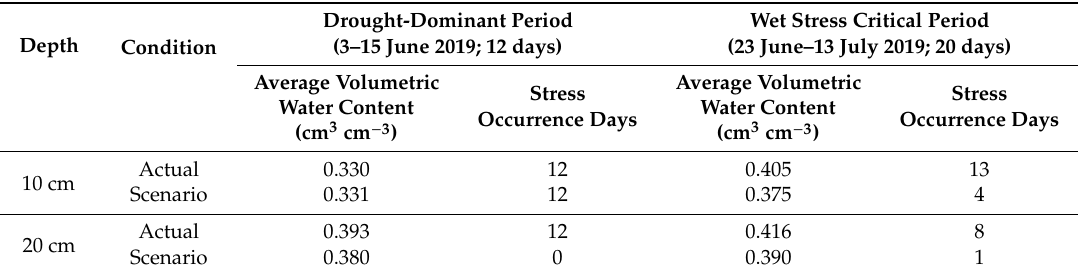
Figure 9. Drought and wet stresses under actual and scenario conditions in 2019. ( a ) Drought stress; ( b ) wet stress. The critical growth periods for drought and wet stresses were defined based on Çakir [3] and Kanwar et al. [4]. Table 6. Average volumetric water content per day and the number of days under stress, under actual and scenario conditions.